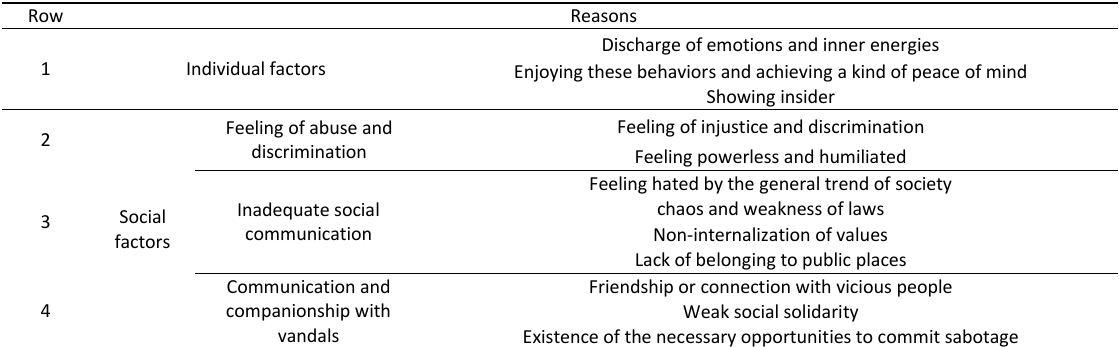
Table 4: Reasons for vandalism (extracted from content analysis of focus group interviews) Row